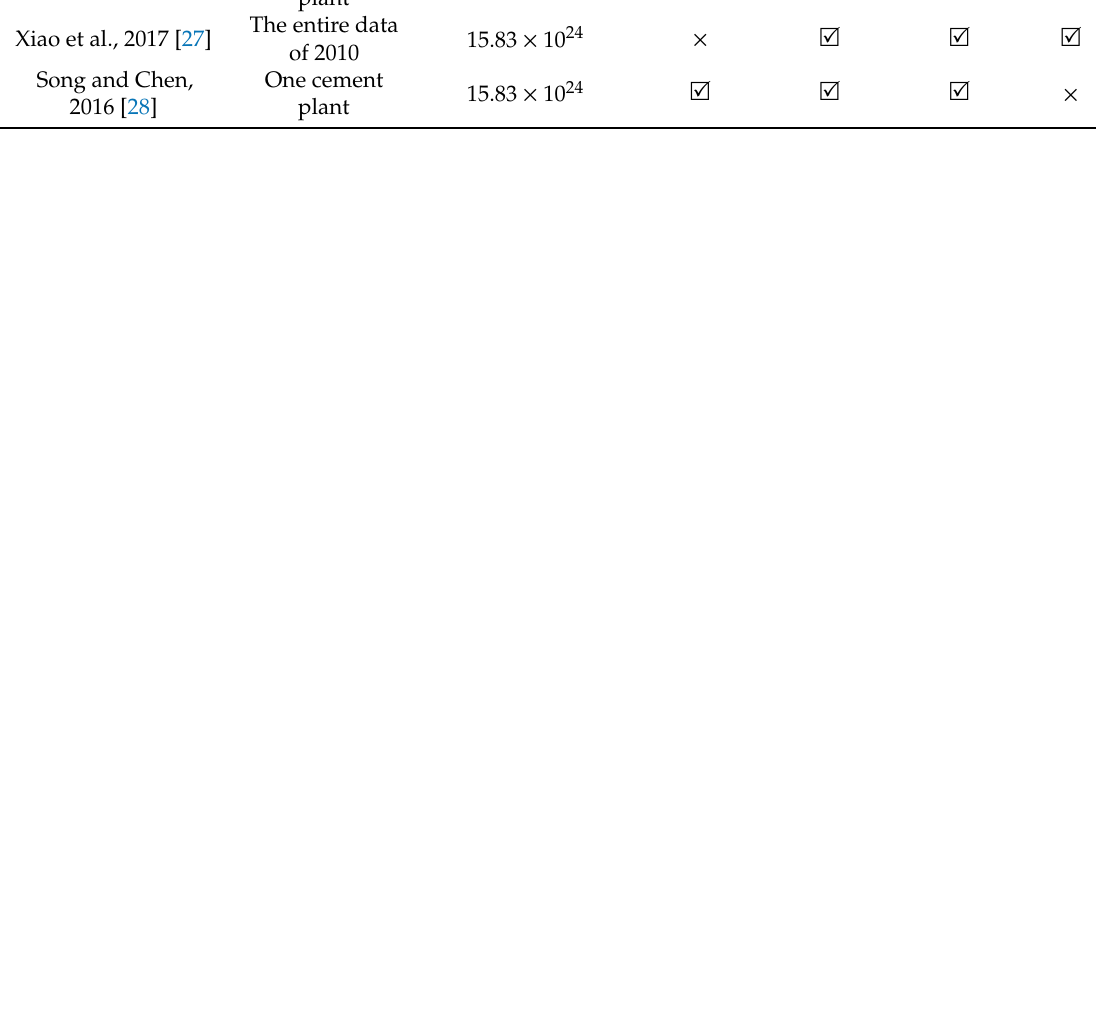
Table 2. Comparison of the unit emergy values (UEVs) of cement manufacturing in China.